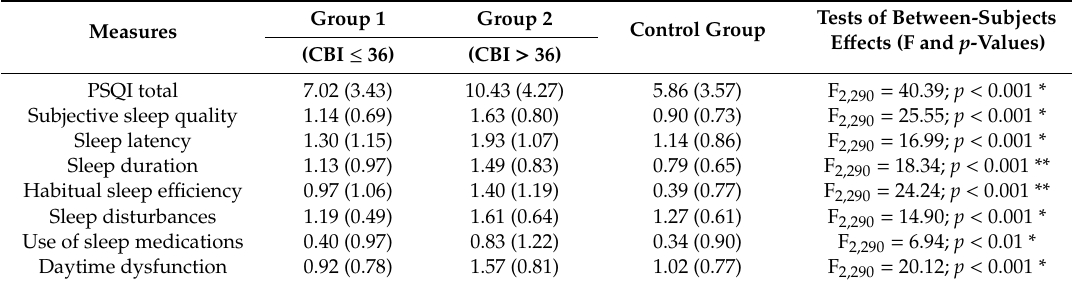
Table 2. Mean scores (standard deviation) for PSQI (total and subscales score) in all the study groups.